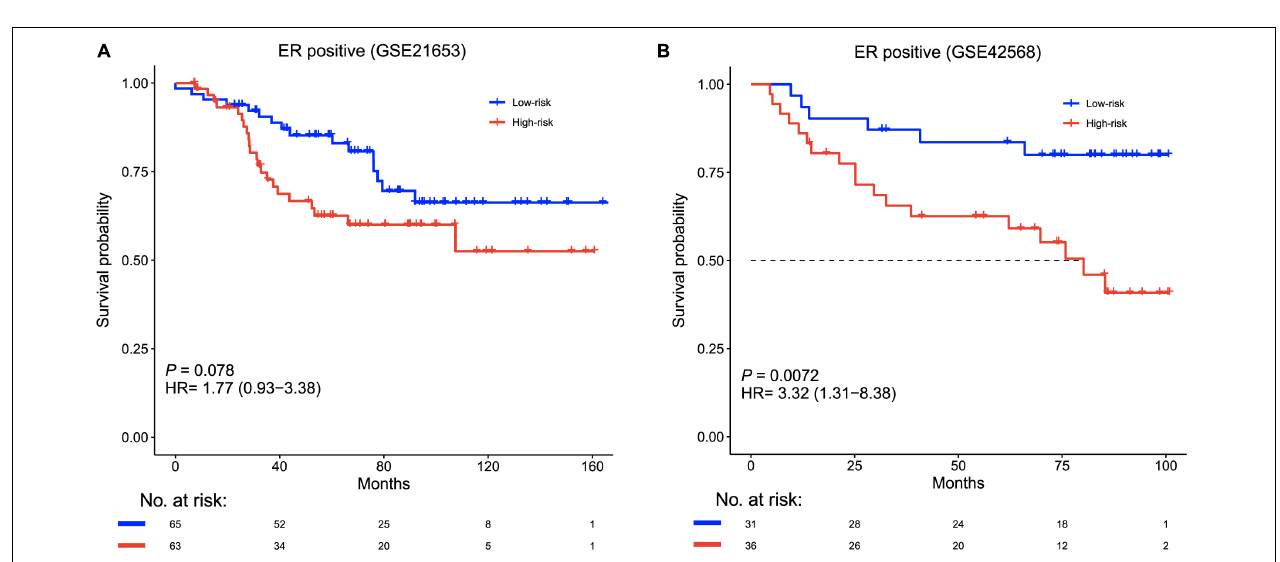
FIGURE 3 | Survival analysis of grade III patients based on the six-lncRNA signature. Kaplan–Meier survival curves for grade III patients in (A) GSE21653 ( n = 117) and (B) GSE42568 ( n = 51).